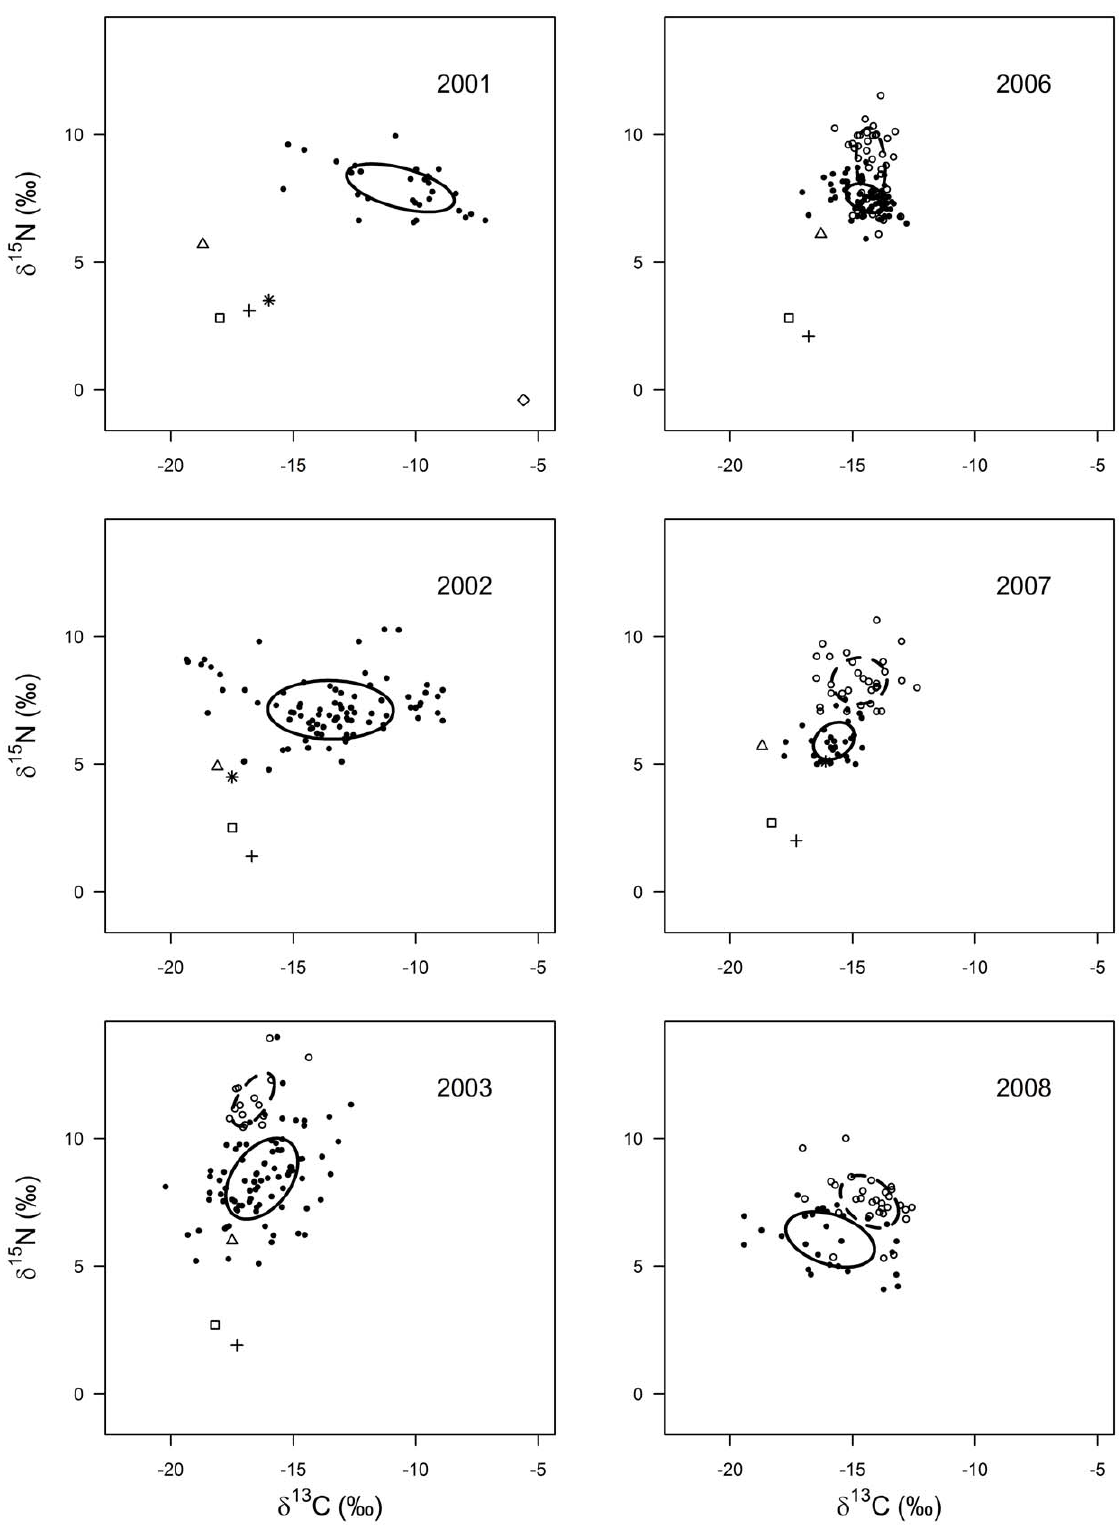
Figure 3. Stable isotope bi-plots for each year, illustrating the isotopic niche of carp and crayfish. The black circles represent individual crayfish and the open circles represent individual carp. The lines enclose the standard ellipse area (SEA c ) for each year for both crayfish (solid) and carp (dashed). Mean values of resource points are also shown; benthic FPOM (open square), plant debris (cross), submerged plants (open diamond), chironomids (open triangle) and oligochaetes (asterisk).